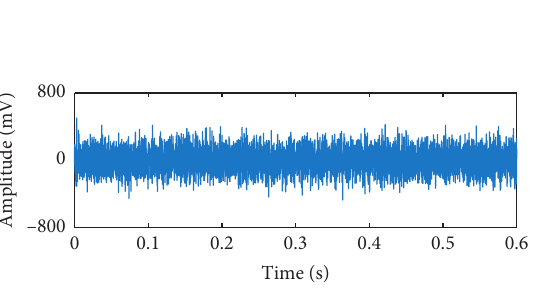
Figure 14: Time-domain waveform of the experimental